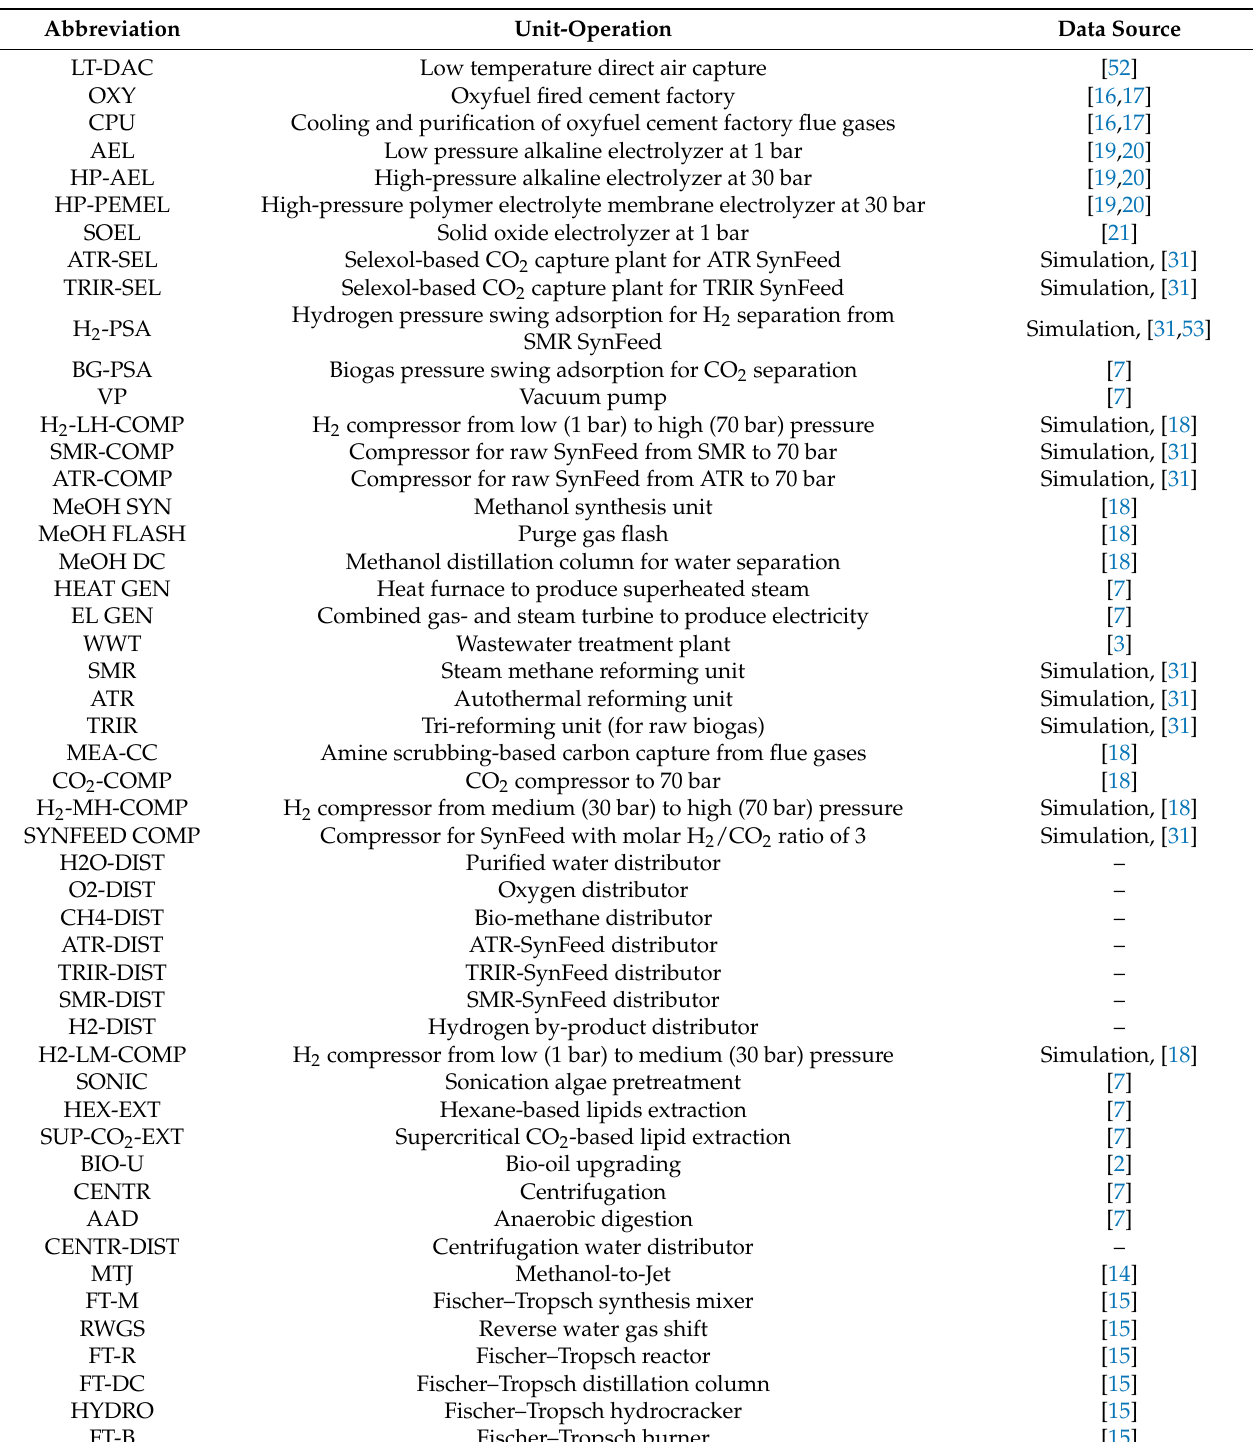
Table A1. List of unit-operations of the renewable refinery superstructure as well as their model data